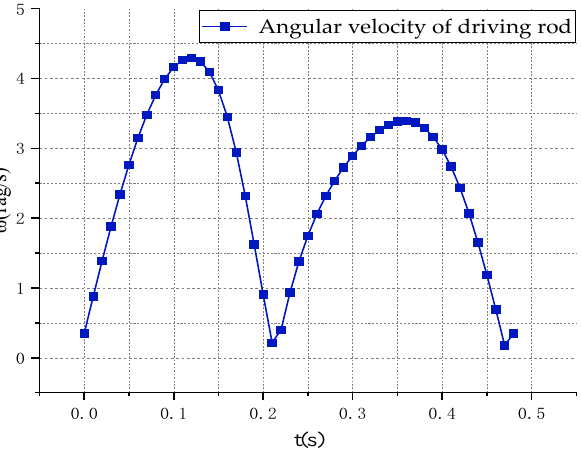
Figure 4. Angular velocity of drive rod.